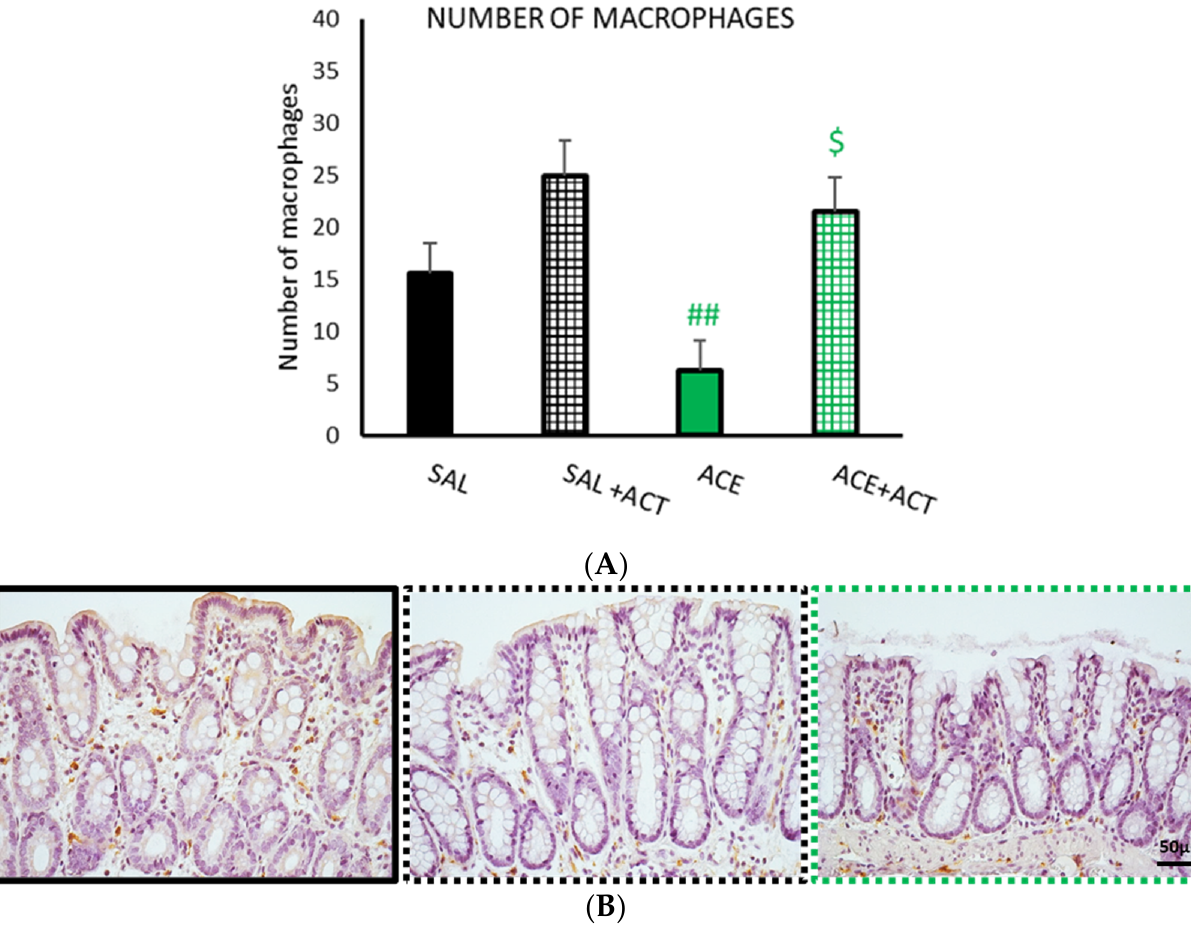
Figure 10. Effects of pretreatment with probiotics on the number of macrophages, phase II. The groups selected in phase I (SAL30 and ACE 0.6% 30, now termed SAL, black bar and ACE, green bar) were compared with the corresponding two groups that were pretreated with 1 mL/day of Actimel ® (ACT), the 7 days before performance of the visceral sensitivity test (SAL + ACT black gridded bar, ACE + ACT green gridded bar). The number of macrophages ( A ) was assessed using immunohistochemical methods in ten random fields per section. Data represent mean ± SEM. ## p < 0.01 vs. SAL+ ACT; $ p < 0.05 vs. ACE + ACT. One-way ANOVA followed by Bonferroni post hoc test. ( B ) Photomicrographs of CD163 immunopositive cells (macrophages) in colonic mucosa after intracolonic administration of SAL (black frame) or in animals pretreated with Actimel ® after intracolonic administration of saline (SAL + ACT; black dotted frame) or 0.6% acetic acid (ACE + ACT; green dotted frame). Scale bar = 50 μm.